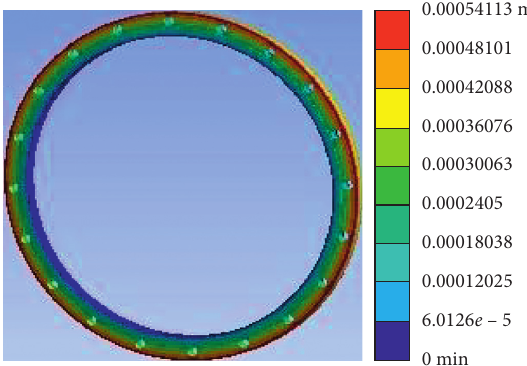
Figure 13: Equivalent strain cloud diagram of the flange.